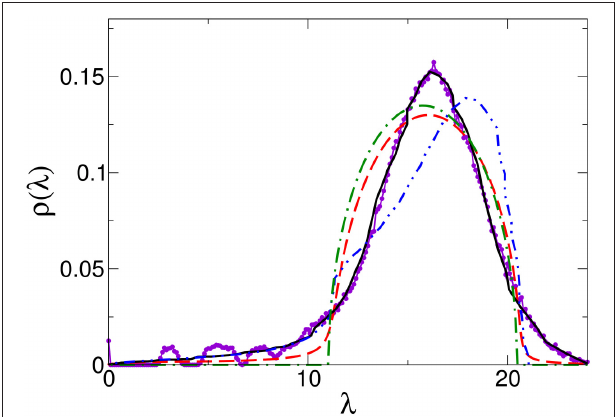
FIGURE 1 | Comparison between the numerically calculated level density ( N 800) for Ŵ 1 (red connected symbols) with the SCERM result of Ganter = = and Schirmacher [1] (blue dash-double dots), our ERM-SCBA result (red dashes) and the half-elliptic DOS (green